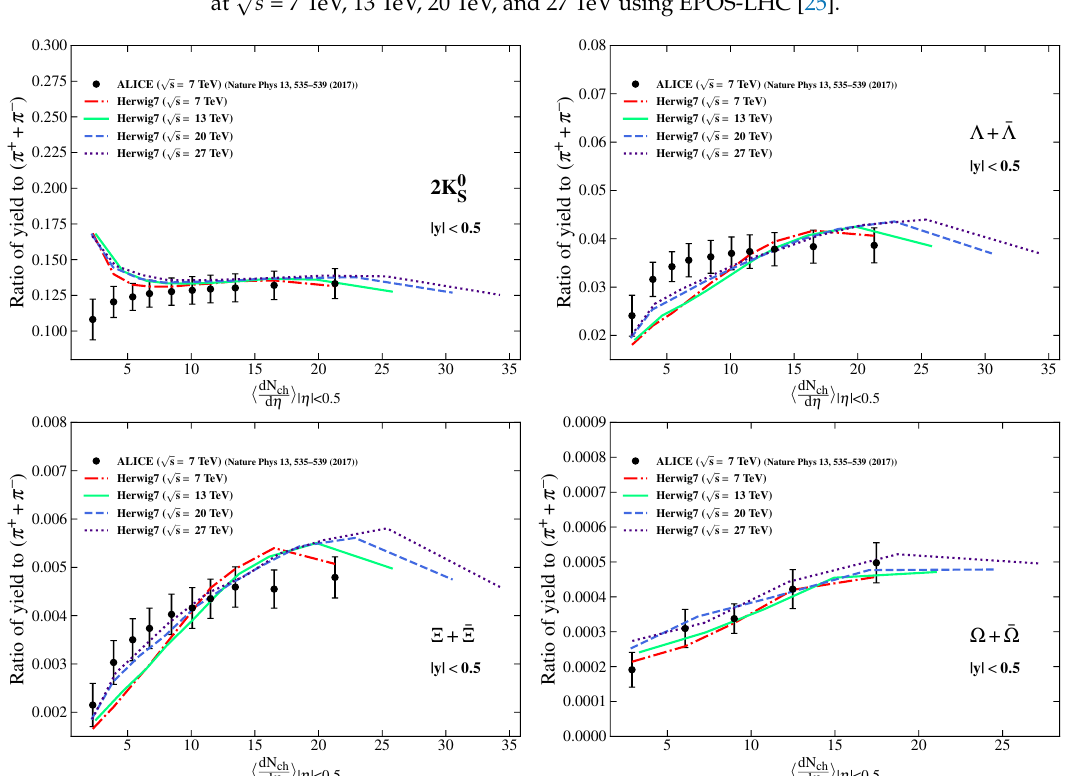
< 0.5 dN ch / d η y measured in (cid:104) (cid:105) | |